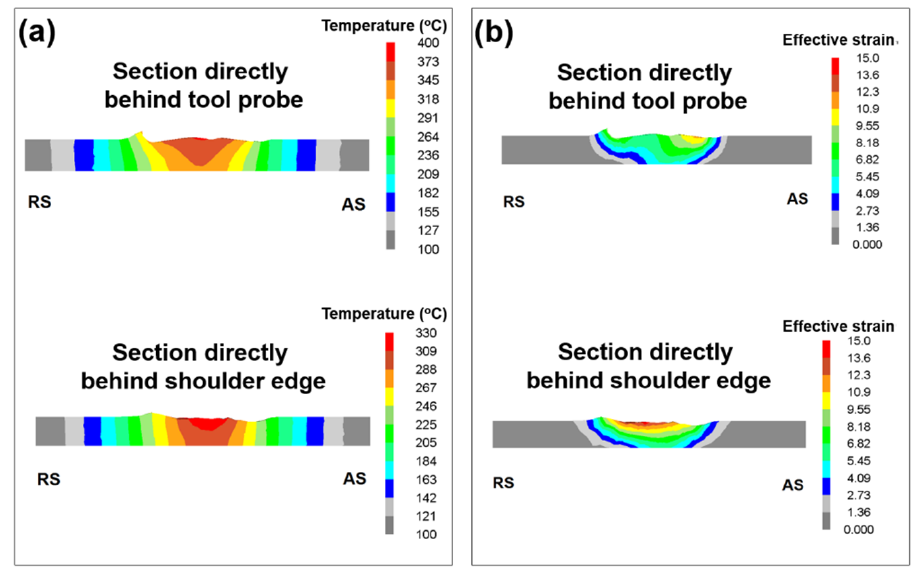
Figure 4. Typical 2-D distributions of temperature ( a ) and cumulative effective strain ( b ) simulated for the weld sections directly behind the tool probe and that behind the shoulder edge. RS and AS are retreating side and advancing side, respectively. Note: The distributions were calculated for 500–380 weld.